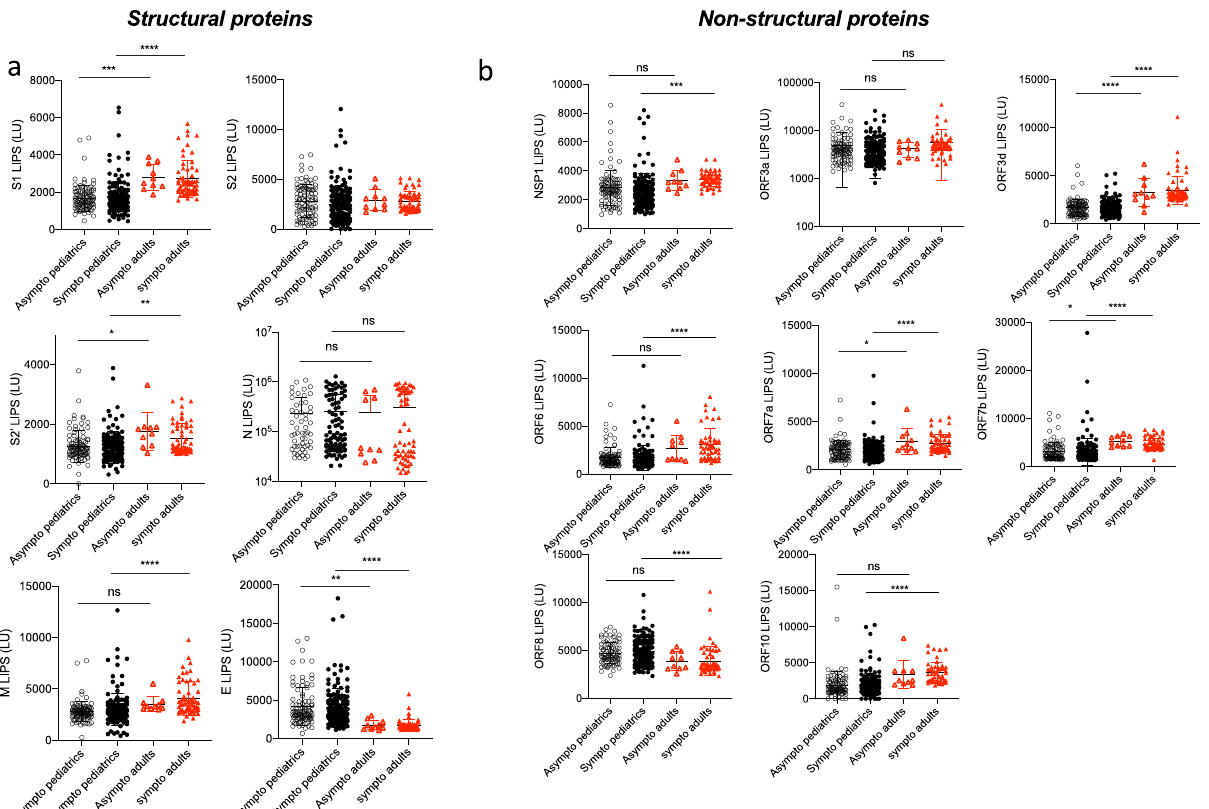
Fig. 4 Asymptomatic and mildly symptomatic children do not display different antibody responses. Pediatric and adult samples were strati fi ed according to the symptom score of the patients (asymptomatic “ asympto ” (pediatric COVID-19 n = 98, adults COVID-19 n = 10) versus symptomatic “ symptom ” (pediatric COVID-19 n = 156, adults COVID n = 52)), data from Figs. 1 and 2 were analyzed according to “ asympto ” and “ sympto ” . a Antibodies against the SARS-CoV-2 structural proteins S1, S2, S2 ′ , N, E, and M by LIPS. Signi fi cant p values for asympto pediatrics versus asympto adults are S1 p = 0.0005, S2 ′ p = 0.0221, E p = 0.0071. Signi fi cant p values for sympto pediatrics versus sympto adults are S1 p < 0.0001, S2 ′ p = 0.0016, M p < 0.0001, E p < 0.0001. b Antibodies against SARS-CoV-2 NSP1 (in ORF1ab), and all other ORFs (ORF3a, ORF3d, ORF6, ORF7a, ORF7b, ORF8, and ORF10). Signi fi cant p values for asympto pediatrics versus asympto adults are ORF3d p < 0.0001, ORF7a p = 0.0358, ORF7b p = 0.0208. Signi fi cant p values for sympto pediatrics versus sympto adults are NSP1 p = 0.0001, ORF3d p < 0.0001, ORF6 p < 0.0001, ORF7a p < 0.0001, ORF7b p < 0.0001, ORF8 p < 0.0001, ORF10 p < 0.0001. Two-sided P values were calculated using the Mann – Whitney U test. * shows statistical signi fi cance between COVID-19 patients versus negative controls. * p < 0.05, ** p < 0.01, *** p < 0.005, **** p < 0,0001. All data represents individual time point LIPS responses and mean ±